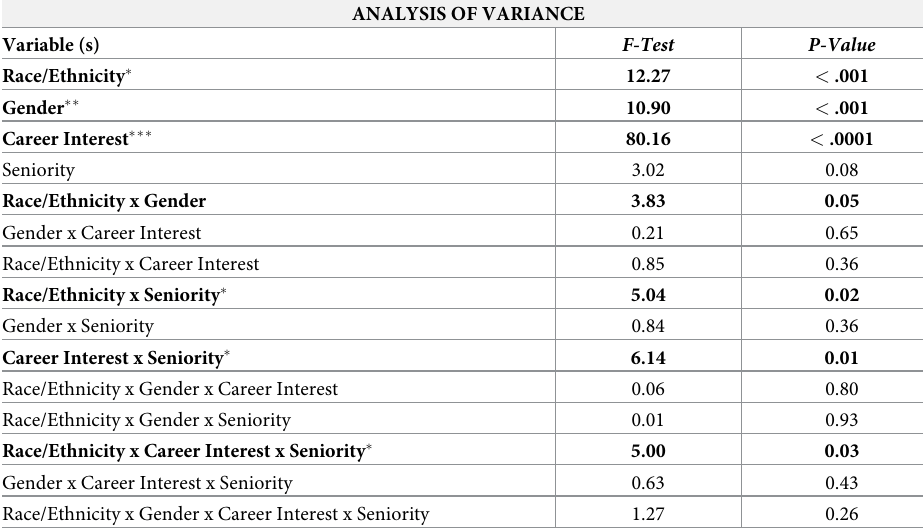
Table 2. 4-Way ANOVA: Race/ethnicity, gender, career interest, seniority.